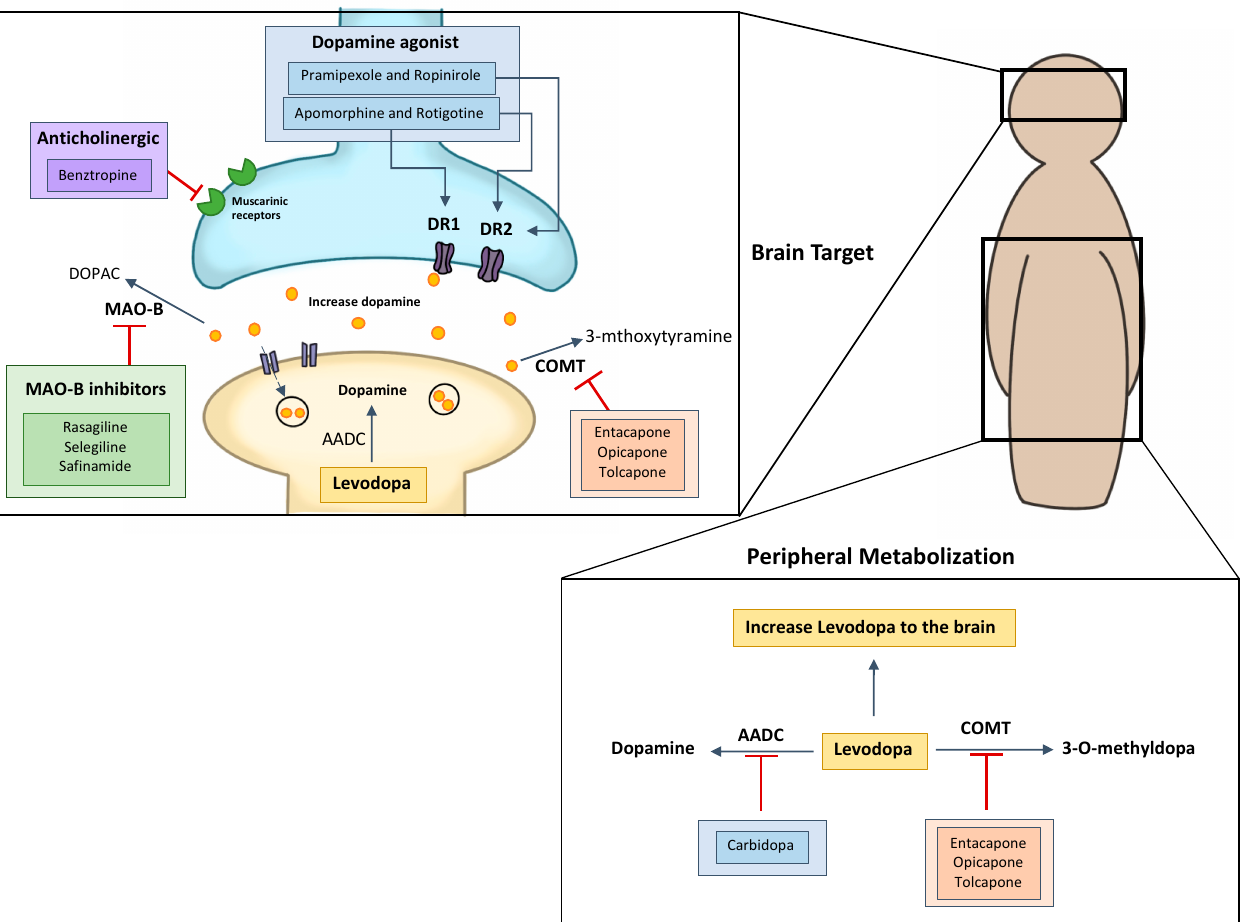
Figure 3. Parkinson’s disease (PD) pharmacotherapy mechanism and sites of action. COMT: Catechol o -methyltransferase; MAO-B: mono-amide oxidase B. Aromatic L-amino acid decarboxylase (AADC); Catechol o -methyltransferase (COMT); mono-amide oxidase B (MAO-B); Dopamine receptors (DR); dihydroxyphenyl acetic acid (DOPAC).